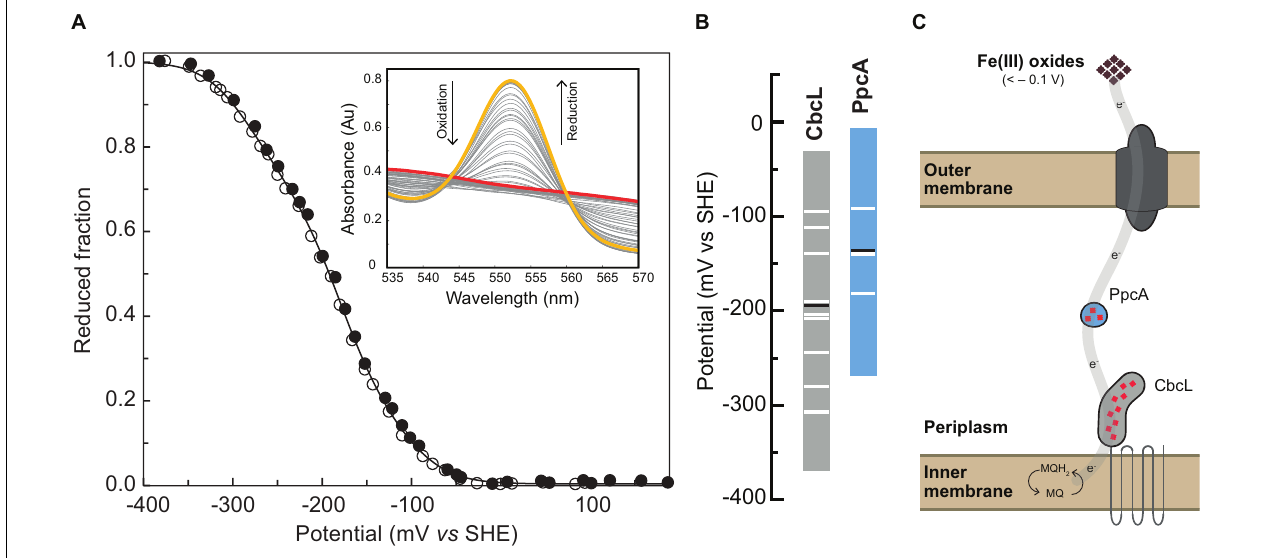
FIGURE 4 | Redox characterization of cytochrome CbcL. (A) Redox titrations at pH 8 monitored by UV-visible spectroscopy. The experimental data are represented by closed (reductive direction) and open (oxidative direction) circles. The solid line represents the fitted curve. The inset shows the α -band region monitored throughout the redox titration. Fully reduced and fully oxidized spectra are represented in yellow and red, respectively. (B) Redox-active windows (1–99% range for protein reduction/oxidation) of CbcL (this work) and PpcA (Morgado et al., 2008) at pH 8. Horizontal black lines correspond to the E app of each cytochrome, and horizontal white lines correspond to the fitted sequential macroscopic reduction potential values. (C) Proposed model for extracellular electron transfer to Fe(III) oxides and electrodes poised at -100 mV in G. sulfurreducens